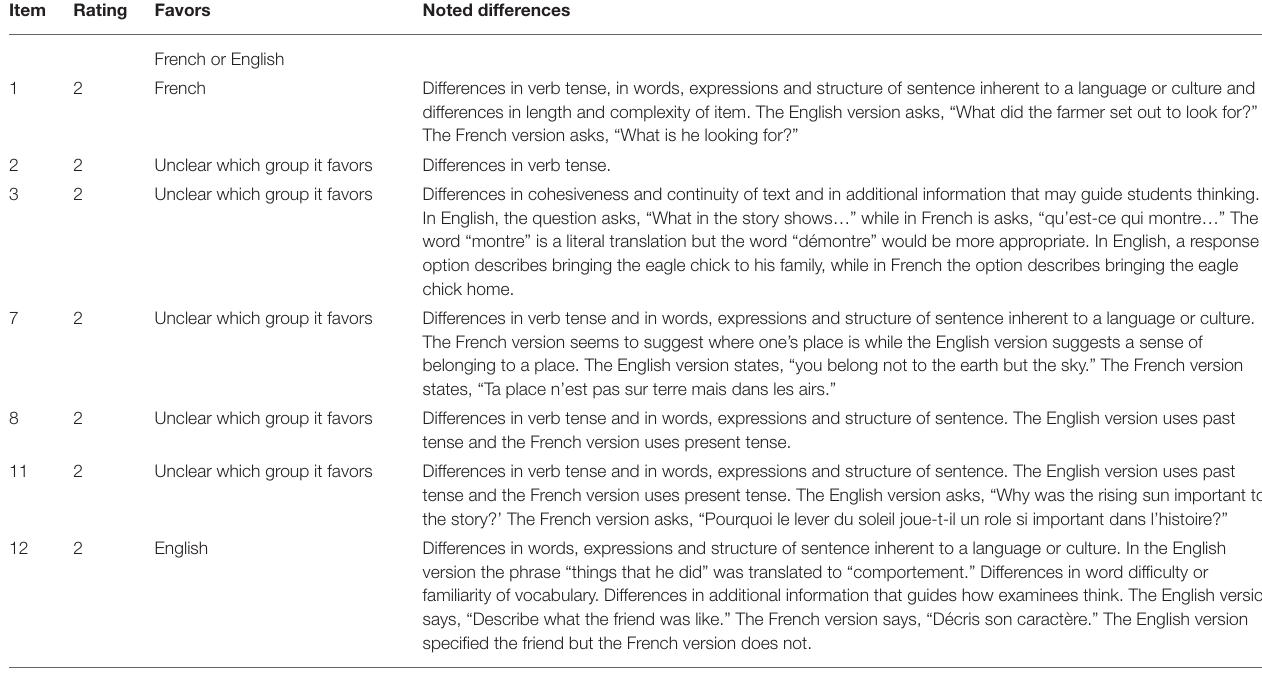
TABLE 5 | Passage 1 “Fly, Eagle, Fly” expert review ratings and noted